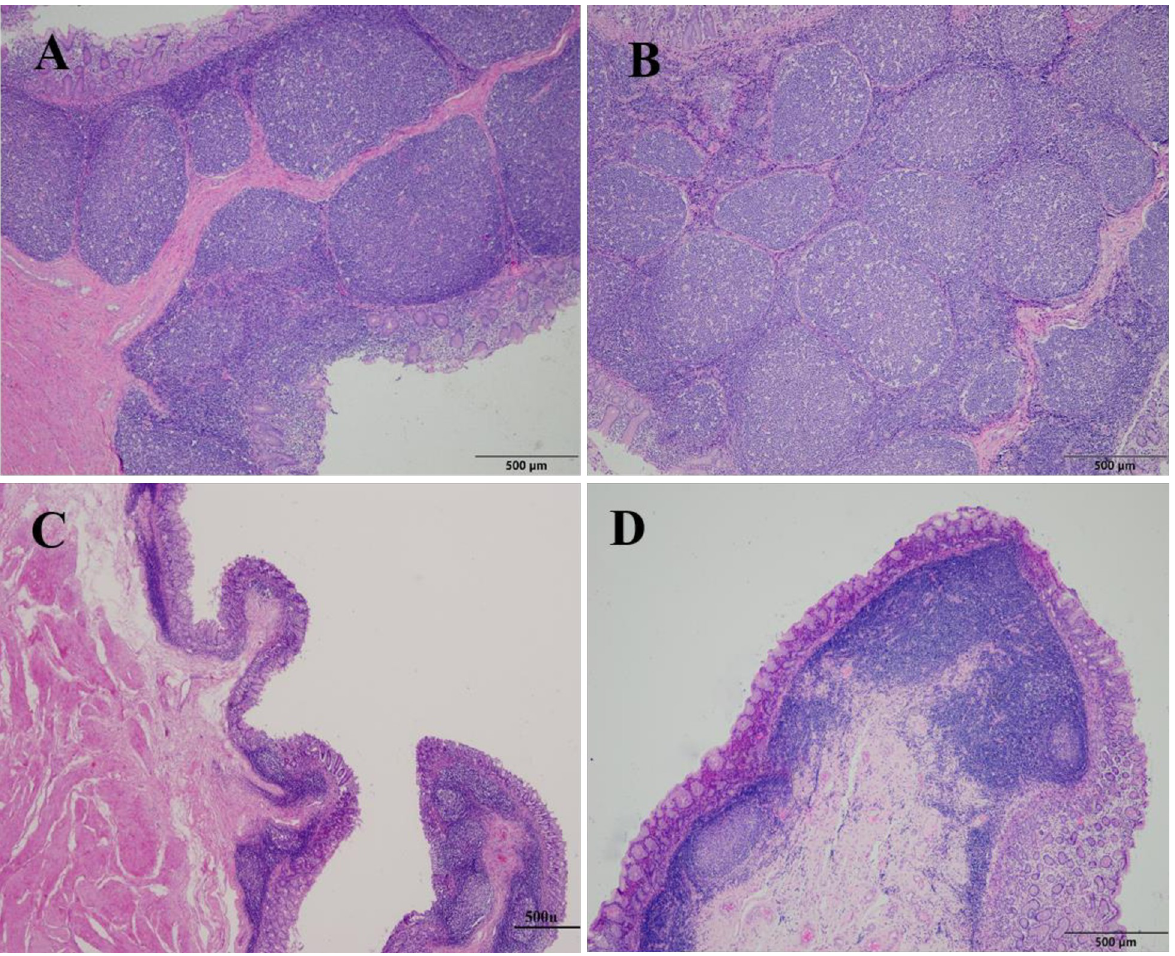
Fig 7. The histological appearance of ALNA. The mucosal folds were well developed and the lymphoid follicles were abundant in young (A) and pubertal (B) but poorly arranged with few follicles in old animals (C and D). In young and pubertal, some mucosal folds were broad and bifurcated (B). A: 7 months old; B: 4 years old; C: 17 years; D: 20 years. H and E (40x).